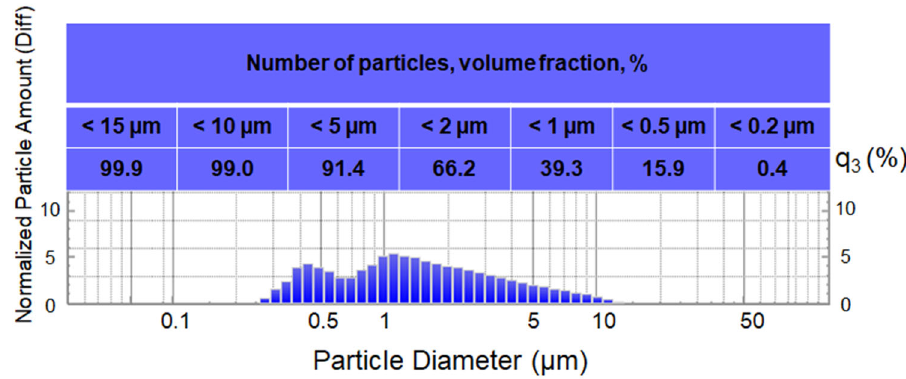
Figure 3. Histogram of particle size distribution.